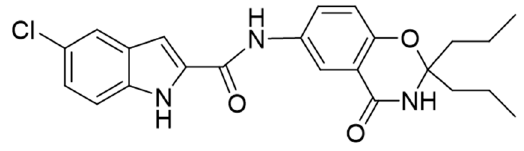
Figure 1. The structure of compound 1.